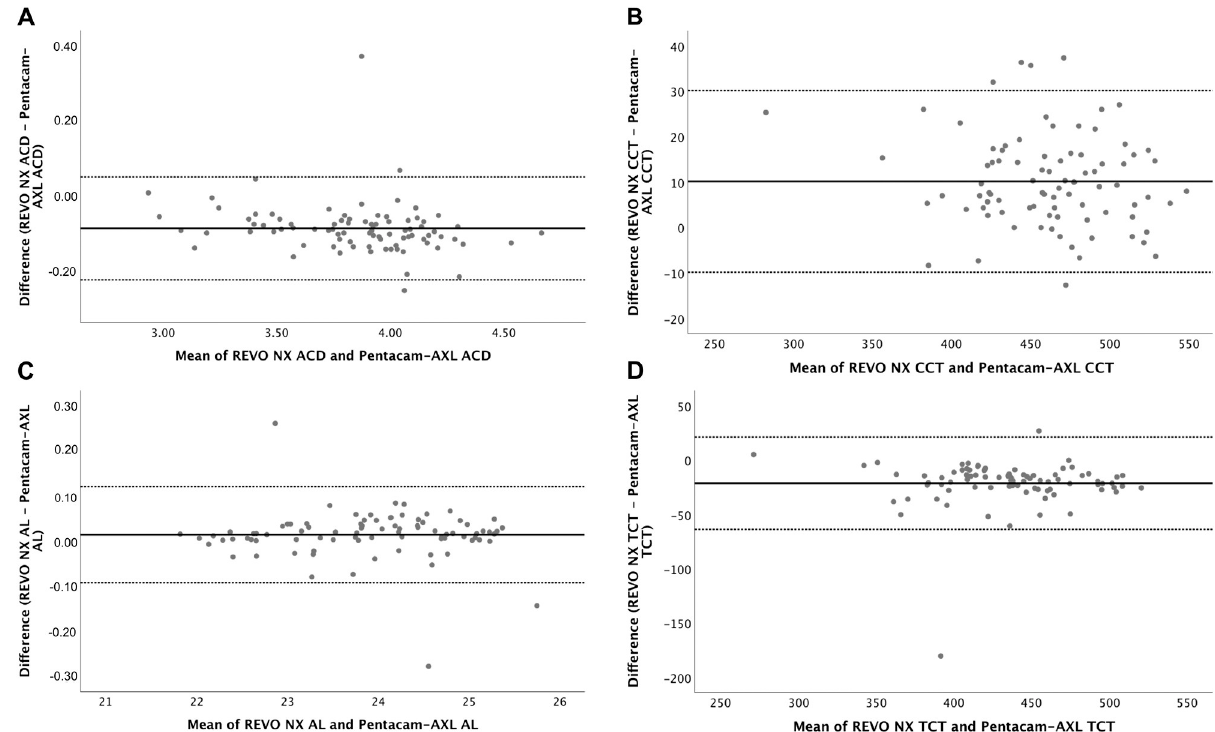
Fig 2. Bland-Altman plots for ACD (2A), CCT (2B), AL (2C), and TCT (2D) for REVO-NX and Pentacam-AXL in Group B eyes. ACD, anterior chamber depth; CCT, central corneal thickness; AL, axial length; TCT, thinnest corneal